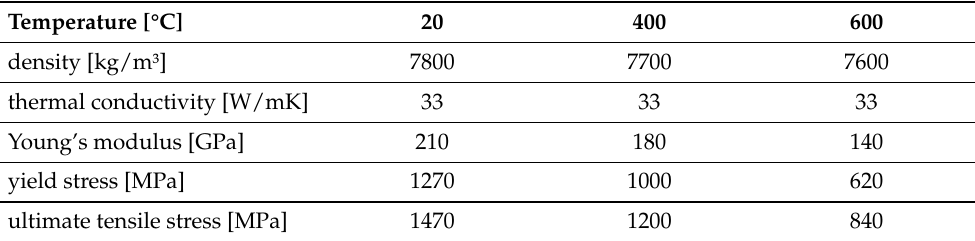
Table 1. Temperature-dependent material properties of QRO ® 90 (hardened and annealed to 45HRC) derived from manufacturer’s information.